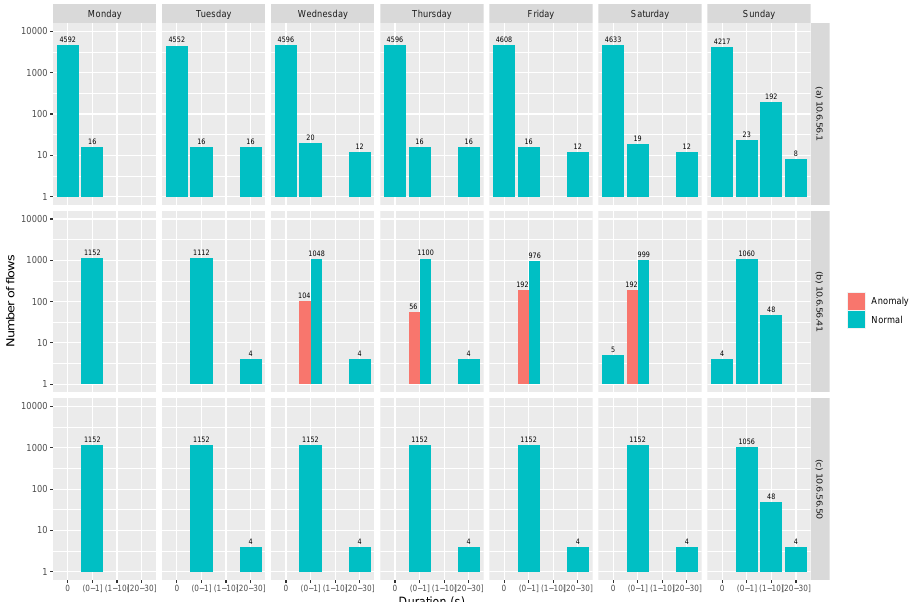
Figure 10. Log-linear flow duration. ( a ) Broker. ( b ) An abnormal node. ( c ) A normal